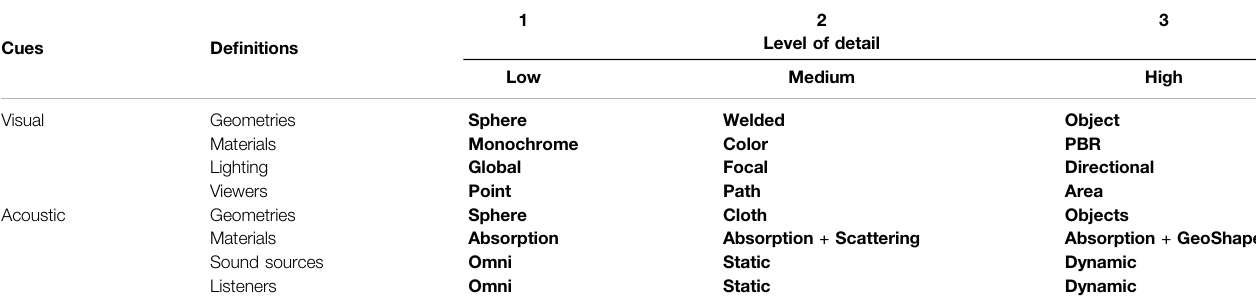
TABLE 1 | Multi-detailed 3D architectural